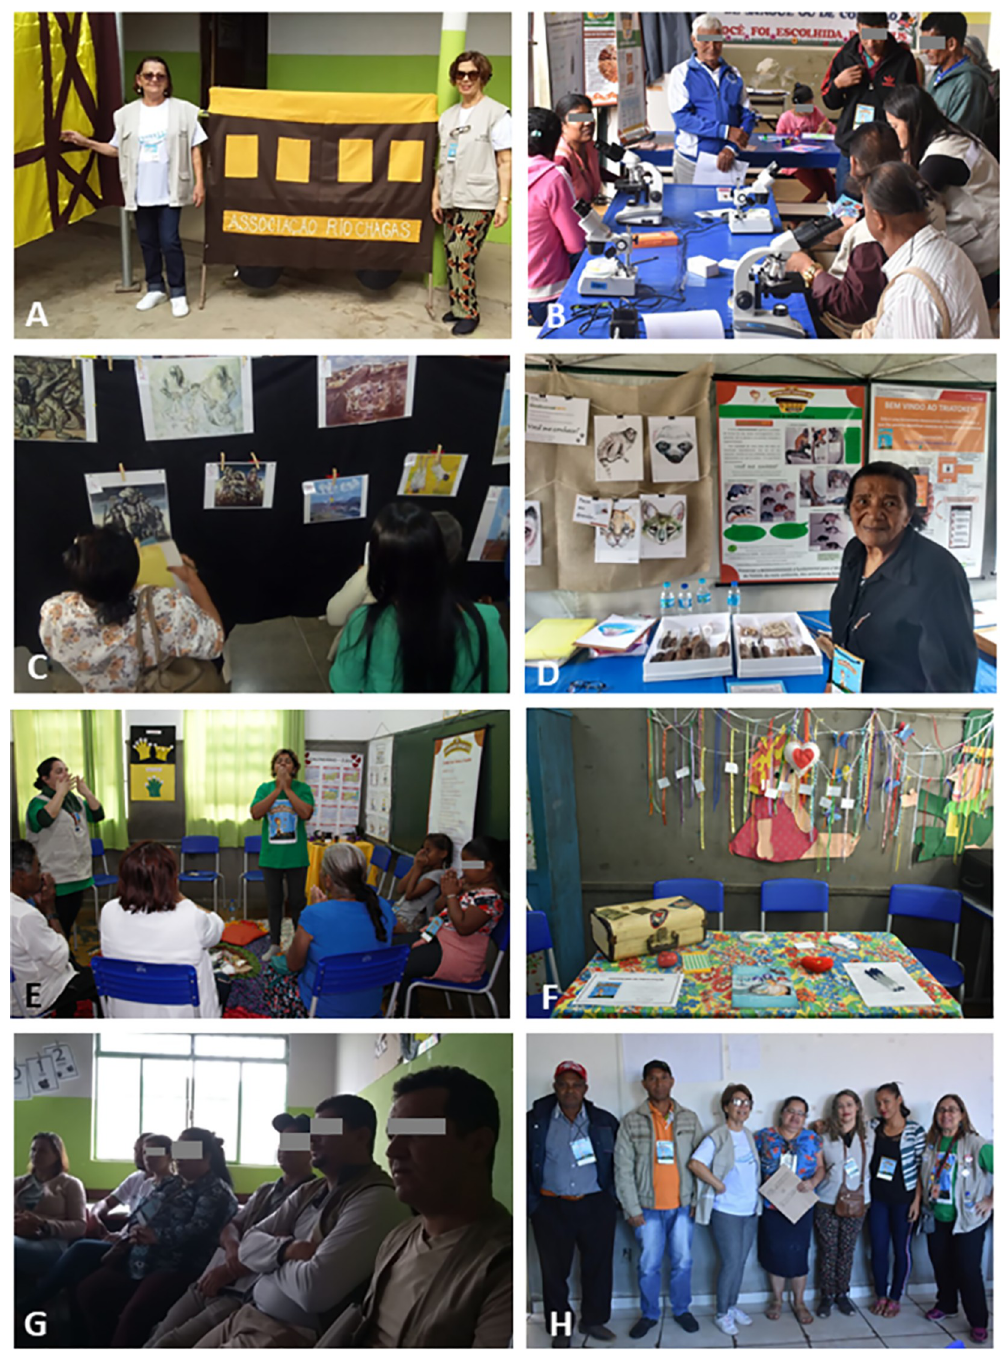
Fig 3. Images from each of the six wagons showing some thematic activities and strategic meetings : (A) wagon 1 with two members of Chagas disease from Rio Chagas Association that follow healthcare in Fiocruz (Rio de Janeiro); (B) wagon 2 with public observing parasites and insects under optical equipment; (C) wagon 3: re-readings of Portinari´s artworks; (D) wagon 4: Biodiversit´Art activities showing animal reservoirs; (E) wagon 5: self-massage workshop with adults and children; (F) wagon 6: craft drapery pending the most important perceptions written or spoken by the participants; (G) mini-courses for health professionals to present the new clinical protocol and therapeutic guidelines for Chagas disease (PCDT-Chagas); (H) compromising participants to organize new associations of CD affected persons, in this case at the city of Gr ã o Mogol during the activities of wagon 1 of Chagas Express XXI in July 2019.